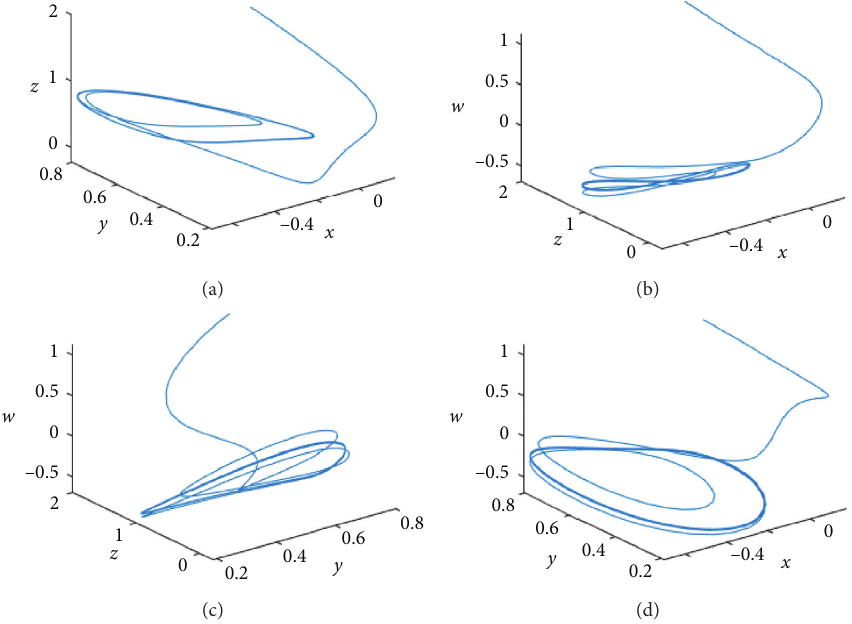
Figure 6: Three-dimensional spatial phase diagram of system (1) with identified parameters.